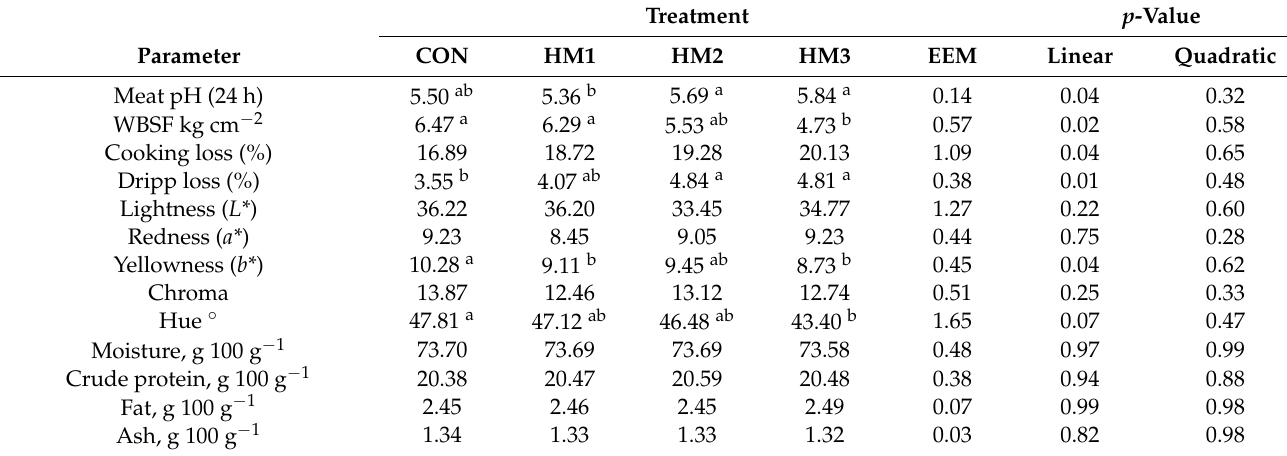
Table 3. Meat characteristics of lambs supplemented with a polyherbal mixture 1 during the final fattening period. Treatment p